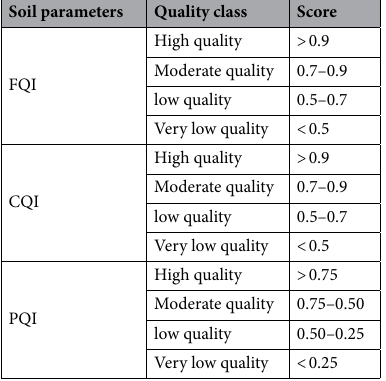
Table 2. Weights of the criteria and scores soil quality classes of the study area 58 .